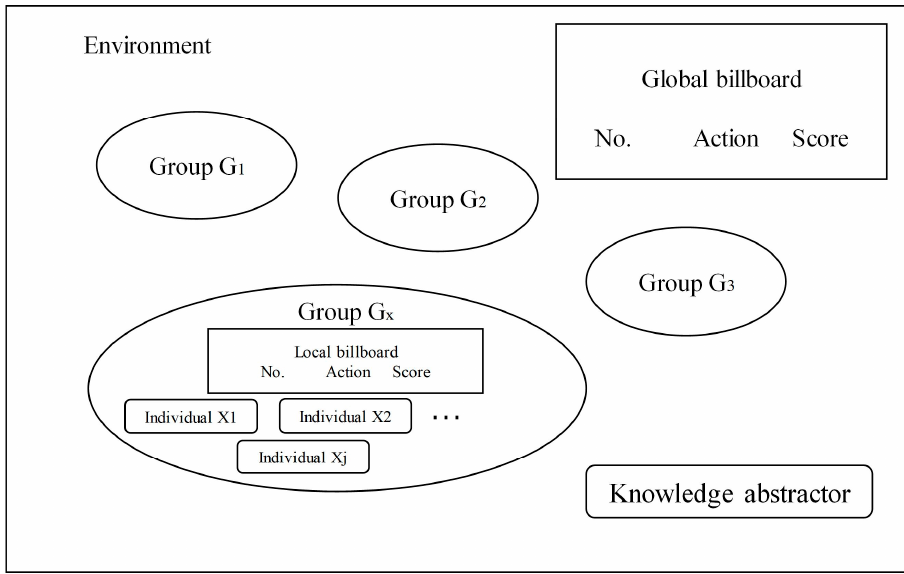
Figure 2. The structure of mind evolutionary computing.